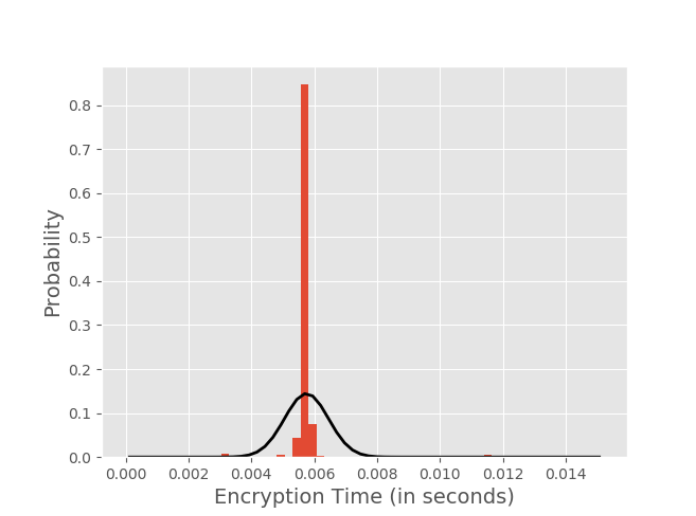
Figure 4: Histogram of the encryption